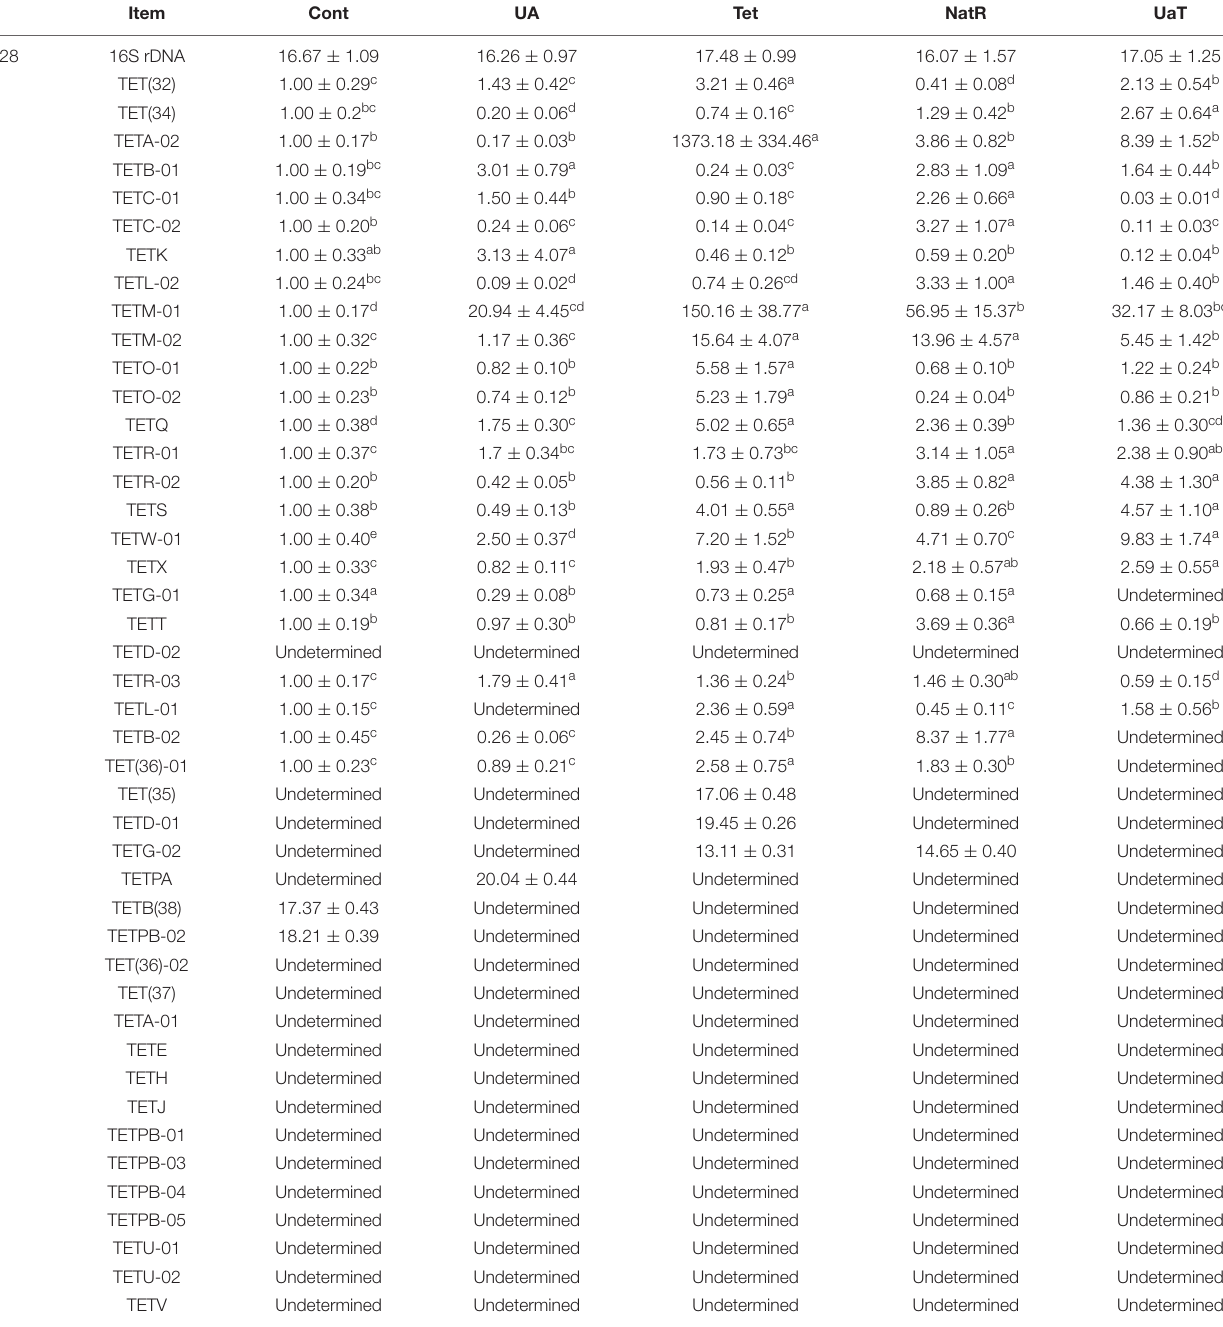
TABLE 4 | Gene expression of tetracycline resistance genes in gut digesta of mice 1